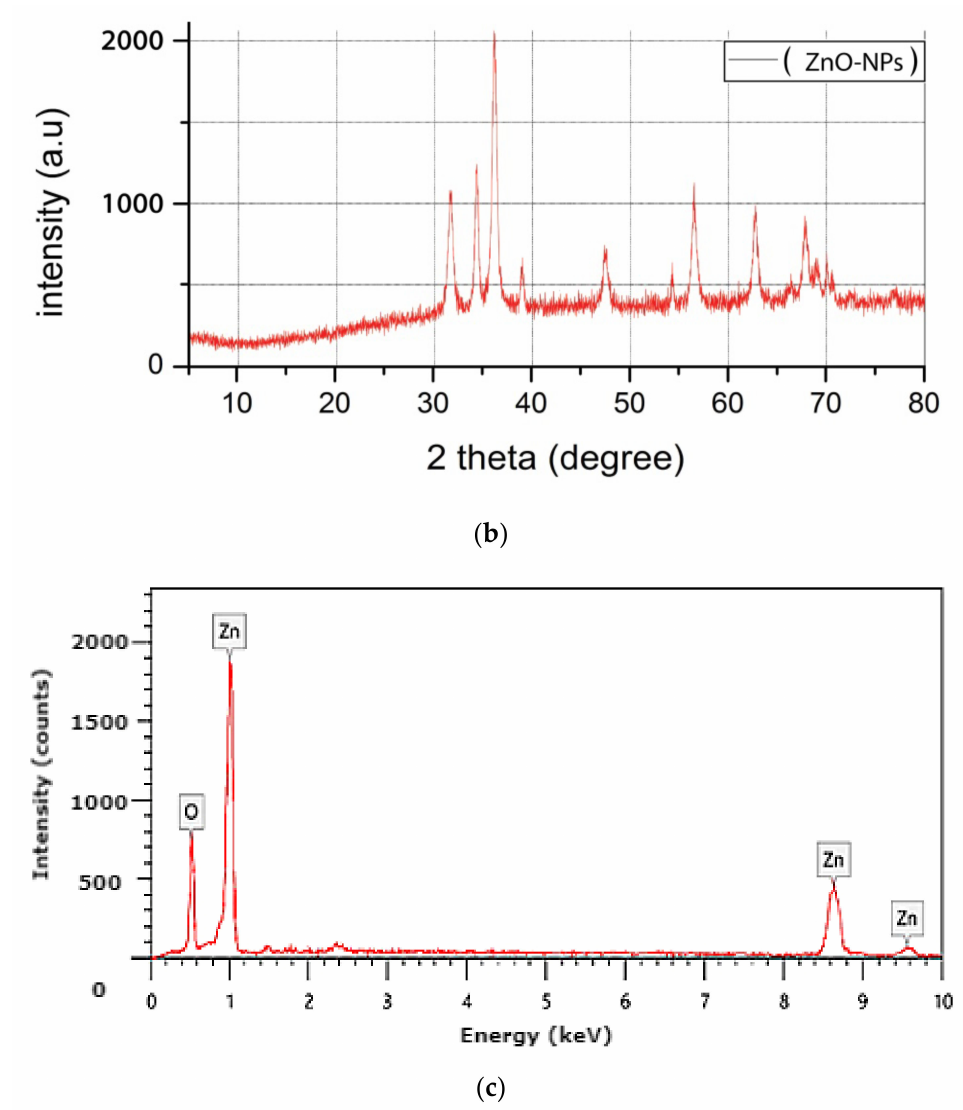
Figure 1. HR-TEM analysis ( a ), XRD analysis ( b ), and energy dispersive X-ray (EDX) ( c ) of the prepared